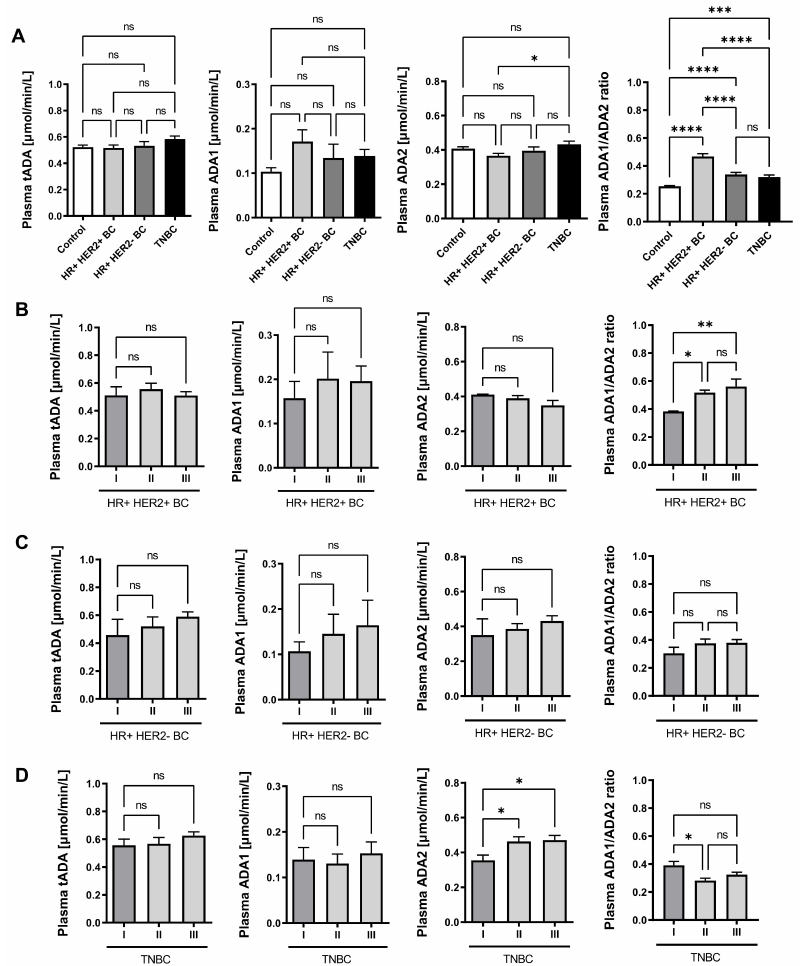
Figure 5. Plasma adenosine deaminase (ADA) activity in breast cancer patients. The activity of total ADA (tADA), ADA1, and ADA2 in healthy controls ( n = 18); estrogen (ER) and progesterone (PR) receptor positive, HER2 positive (HR+ HER2+ BC, n = 12); ER and PR positive, HER2 negative (HR+ HER2- BC, n = 16); and triple negative (TNBC, n = 19) breast cancer patients ( A ); in HR+ HER2+ BC/ HR+ HER2- BC/ TNBC patients with different stages of cancer development (I stage: n = 3/7/7; II stage: n = 6/4/5; III stage: n = 3/4/7) ( B ). Results are shown as mean ± SEM, * p < 0.05, ** p < 0.01, *** p < 0.0001, **** p < 0.00001 by one-way ANOVA followed by Holm-Sidak post hoc test ( A , C, and D ) and Kruskal-Wallis test followed by Dunn’s post hoc test ( B